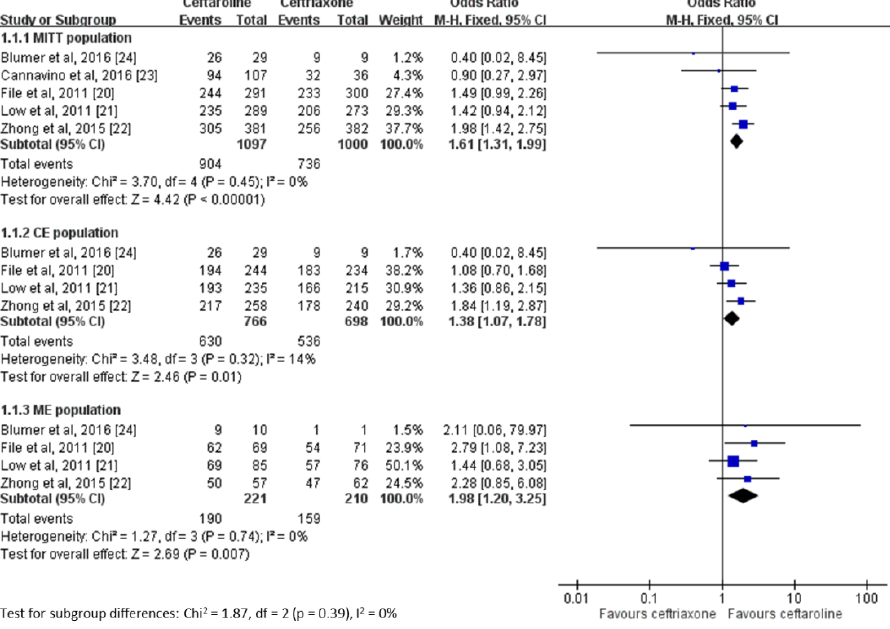
Figure 3. Overall clinical cure rates of ceftaroline and ceftriaxone for the treatment of community- acquired pneumonia. MITT, modified intent-to-treat population; CE, clinically evaluable; ME, microbiologically evaluable.